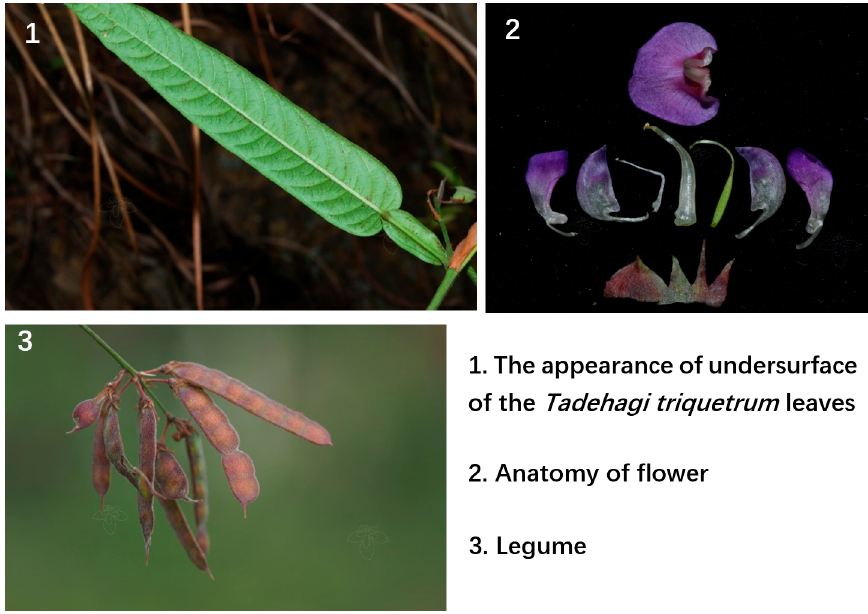
Figure 1. The picture shows the morphological features of the leaves, flowers, and fruits of T. triquetrum (L.) Ohashi.